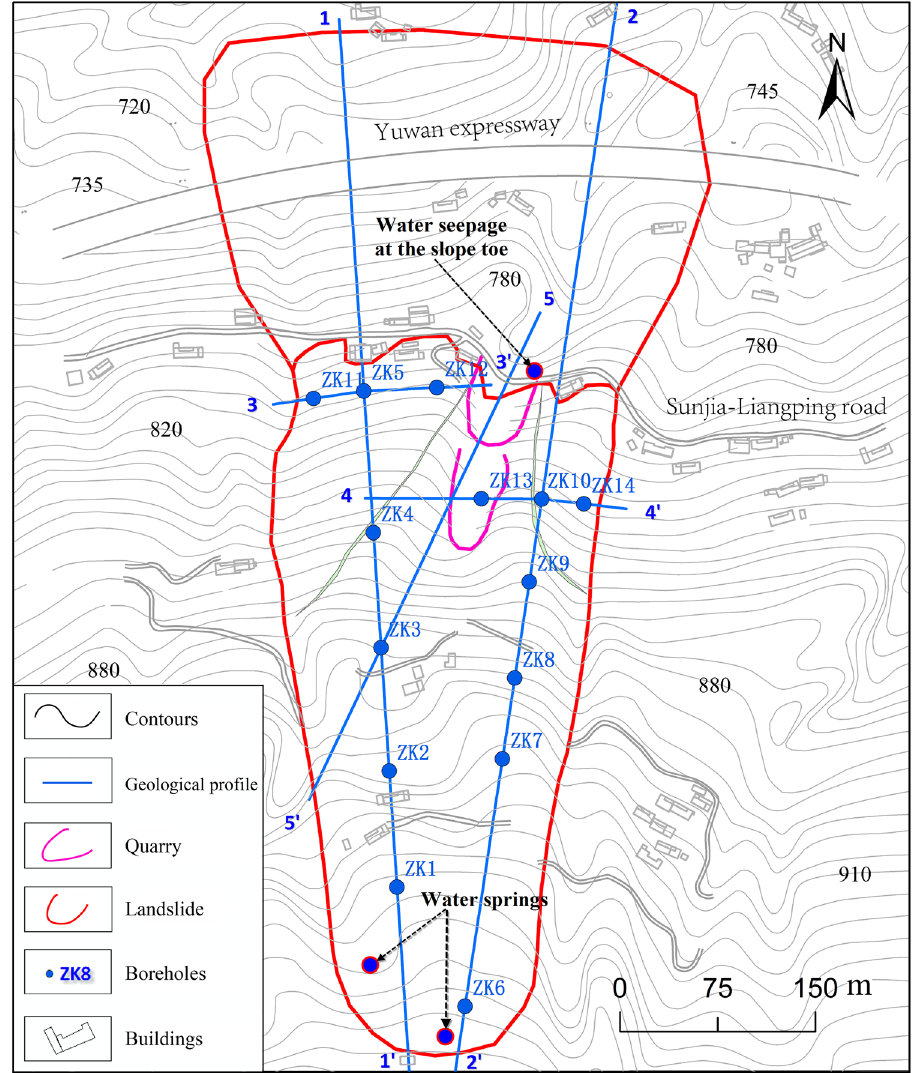
Fig. 2 Geomorphic map of the 2013 Sunjia landslide site in Wanzhou County. The blue dots represent the locations of the boreholes and the black numbers mark the elevation of the altimetric points. The grey double-lined polygons reveal the damaged rural roads Source Wang et al.